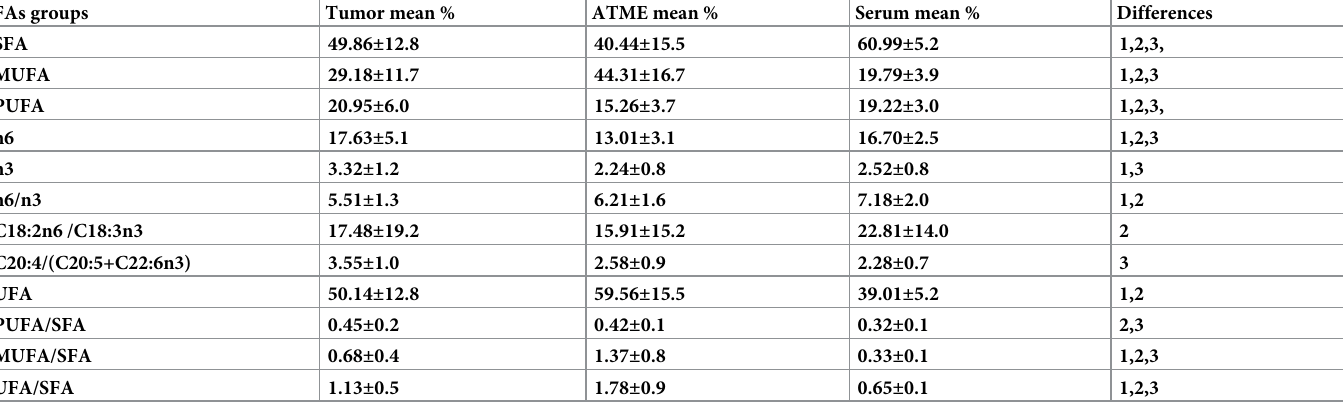
Table 3. Percentage of content of FAs groups: SFA, UFA, MUFA, PUFA, series n6 and n3 of PUFA and ratios C18:2n6/C18:3n3, C20:4/(C20:5+C22:6n3) in tumor, ATME and blood